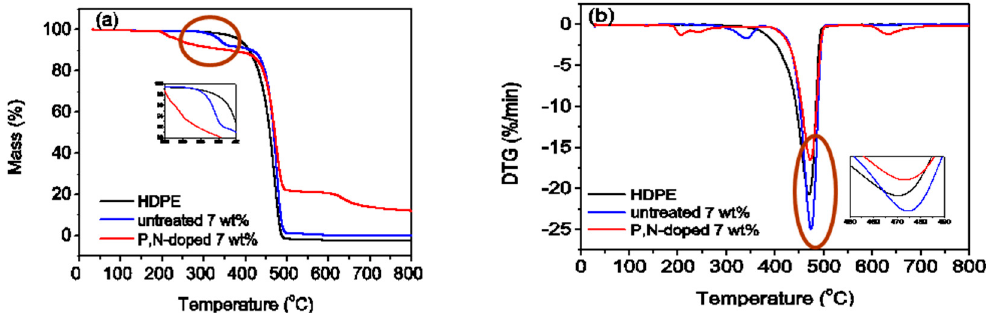
Figure 5. Thermal results of HDPE composites exposed to a nitrogen atmosphere ( a ) TG, and ( b ) DTG.